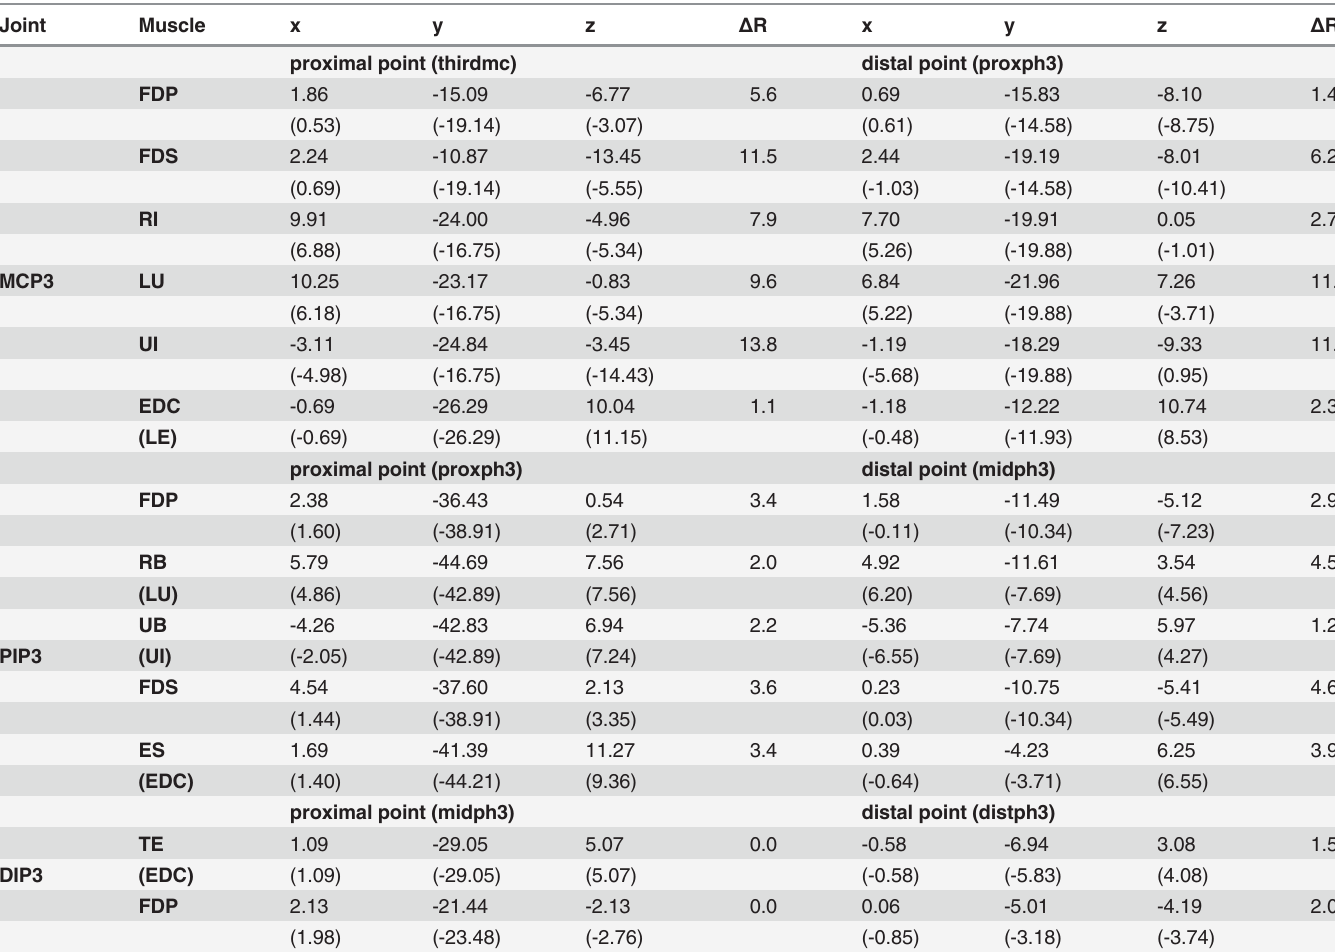
Table 8. Middle finger muscle-tendon locations, expressed in OpenSim frame